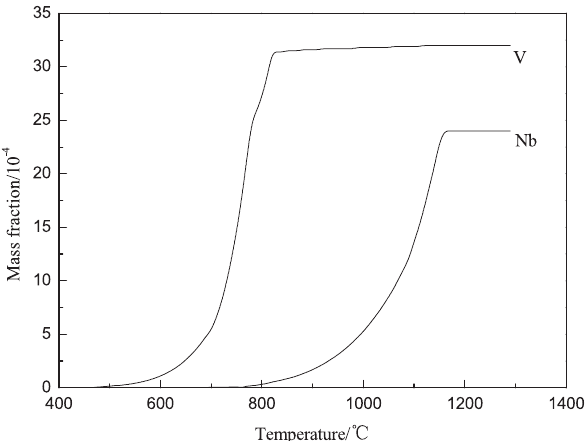
Fig. 3 indicates that equilibrium solution tempera- ture of Nb in Q345E is 1150 °C, and that of V is 780 °C. This means that when the temperature is higher than 1150 °C, no carbonitride of Nb and V precipitate. Below 1150 °C, the solubility of Nb suddenly decreases, and reaches almost zero at 800 °C. Thus the precipitation temperature range for Nb is between 1150 and 800 °C. The similar trend is also valid to V, and the difference is the temperature range. For V, it is between 780 °C and 500